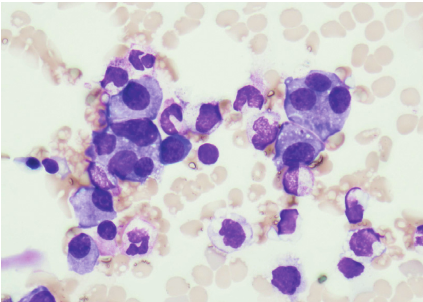
Figure 6: Findings of bone marrow aspiration. Bone marrow aspiration demonstrated an increase of atypical plasma cells of up to 28.8% of the marrow